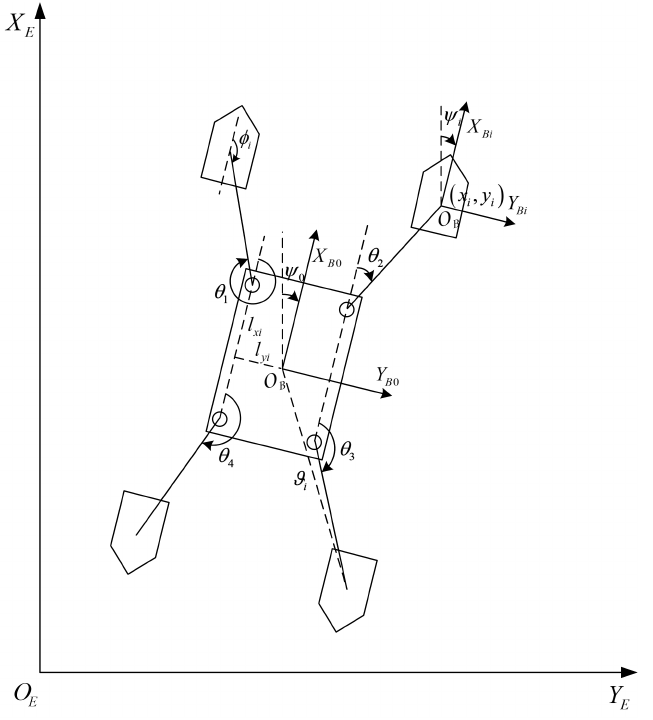
Figure 1. Configuration of four vessels and an unactuated floating object for cooperative